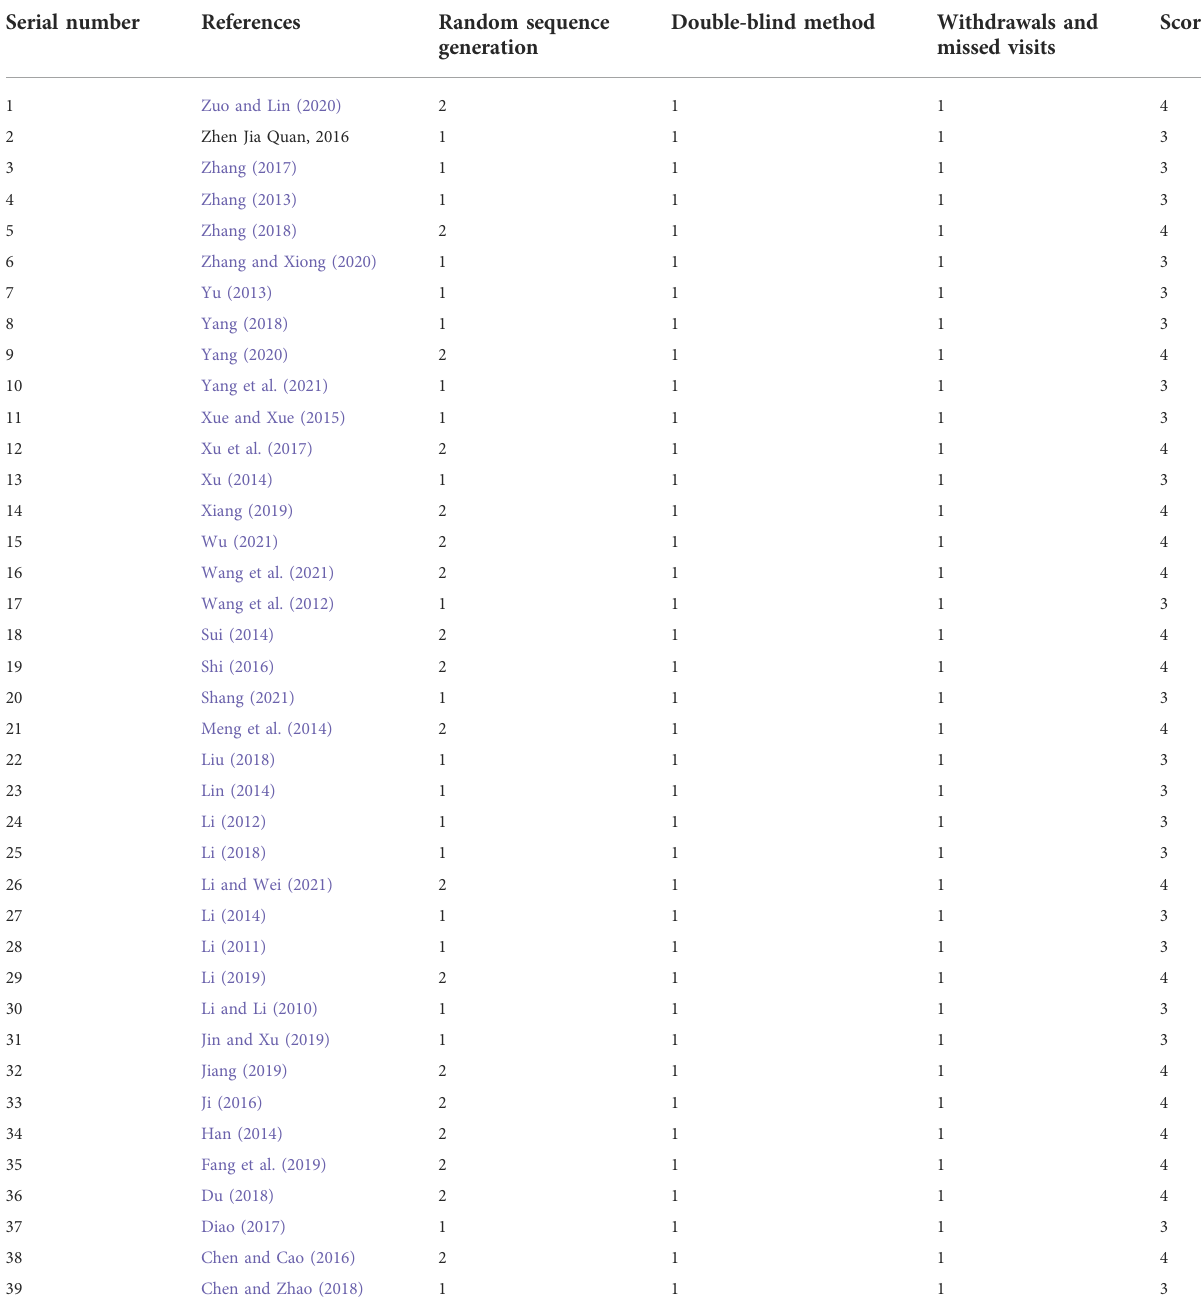
TABLE 4 The methodological quality of the included trials assessed using the Jadad scale quality